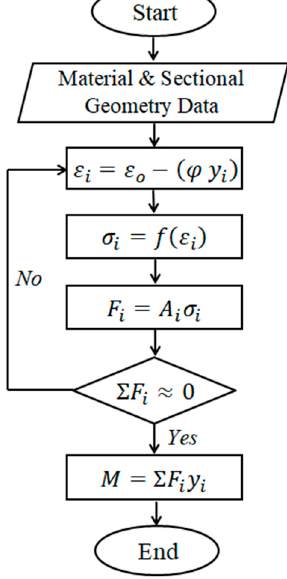
Figure 5. The algorithm of the computation procedure.